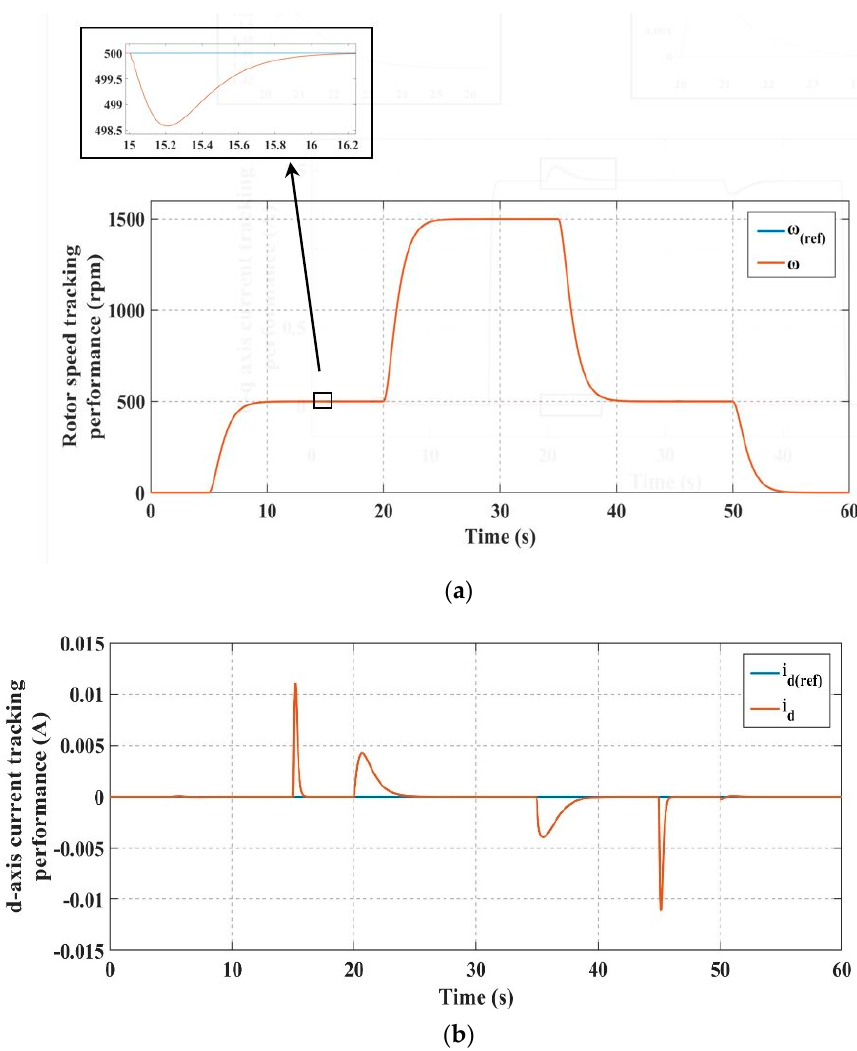
Figure 7. Motor M 8 tracking performance. ( a ) Speed; ( b ) d-q axis currents.